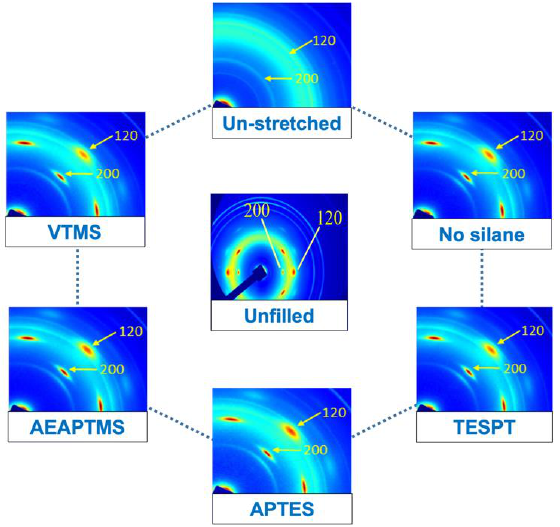
Figure 12. 2D WAXS images of unstretched and 400% stretched NR and NR/HNT composites filled with and without silane coupling